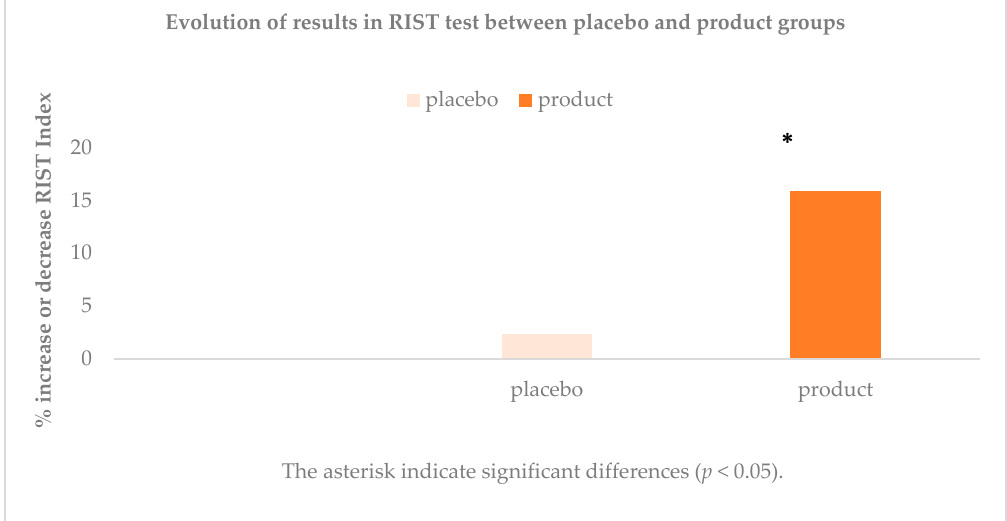
Figure 3. Evolution of results in the different variables of TESEN test in percentage increase or decrease. * indicate significant differences. ( p < 0.05).